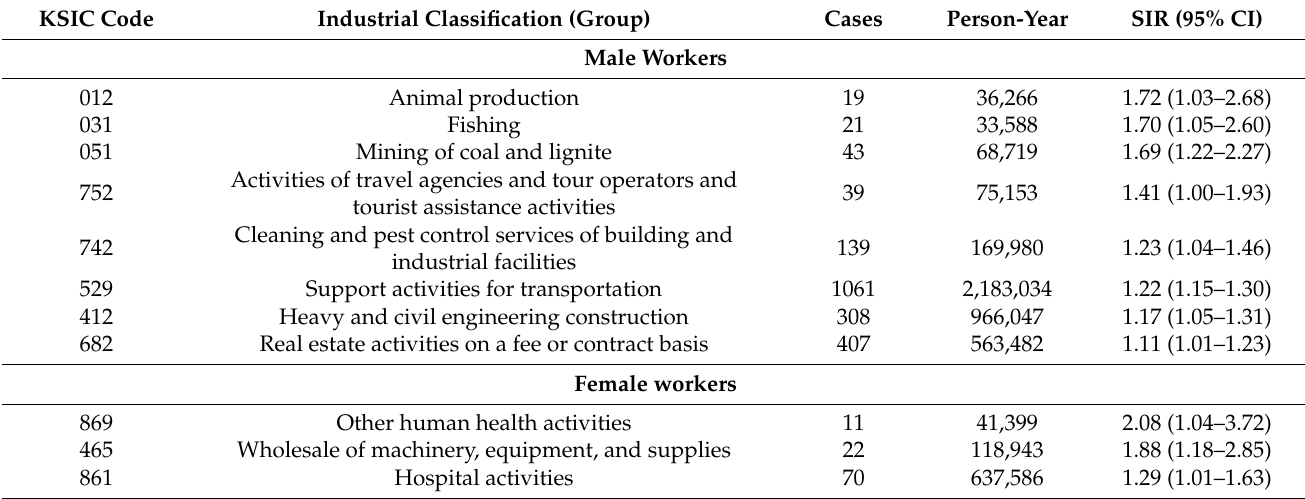
Table 3. Industry groups with a significantly higher risk of laryngeal cancer.